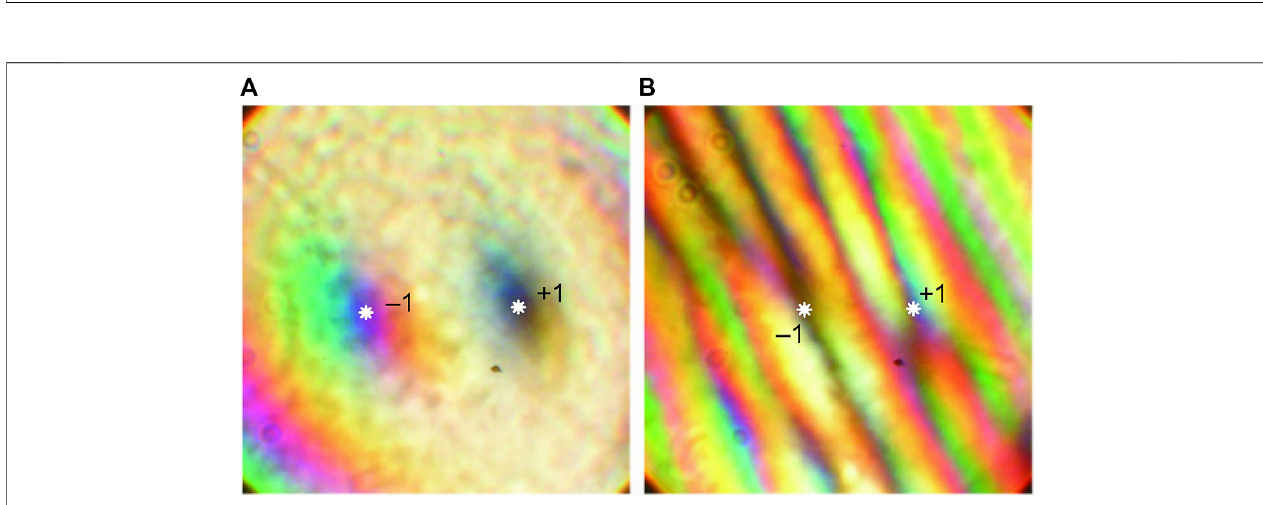
FIGURE2| Singularitiesobtainedinawhite-lightbeamafter passingabiaxialcrystalplacedbetweenthematchedpolarizer P1andtheanalyzerP2(see Figure1 ): (A) without reference wave; (B) with a reference wave [27]. The topological charges are indicated of the two singularities with exact locations marked by asterisks.